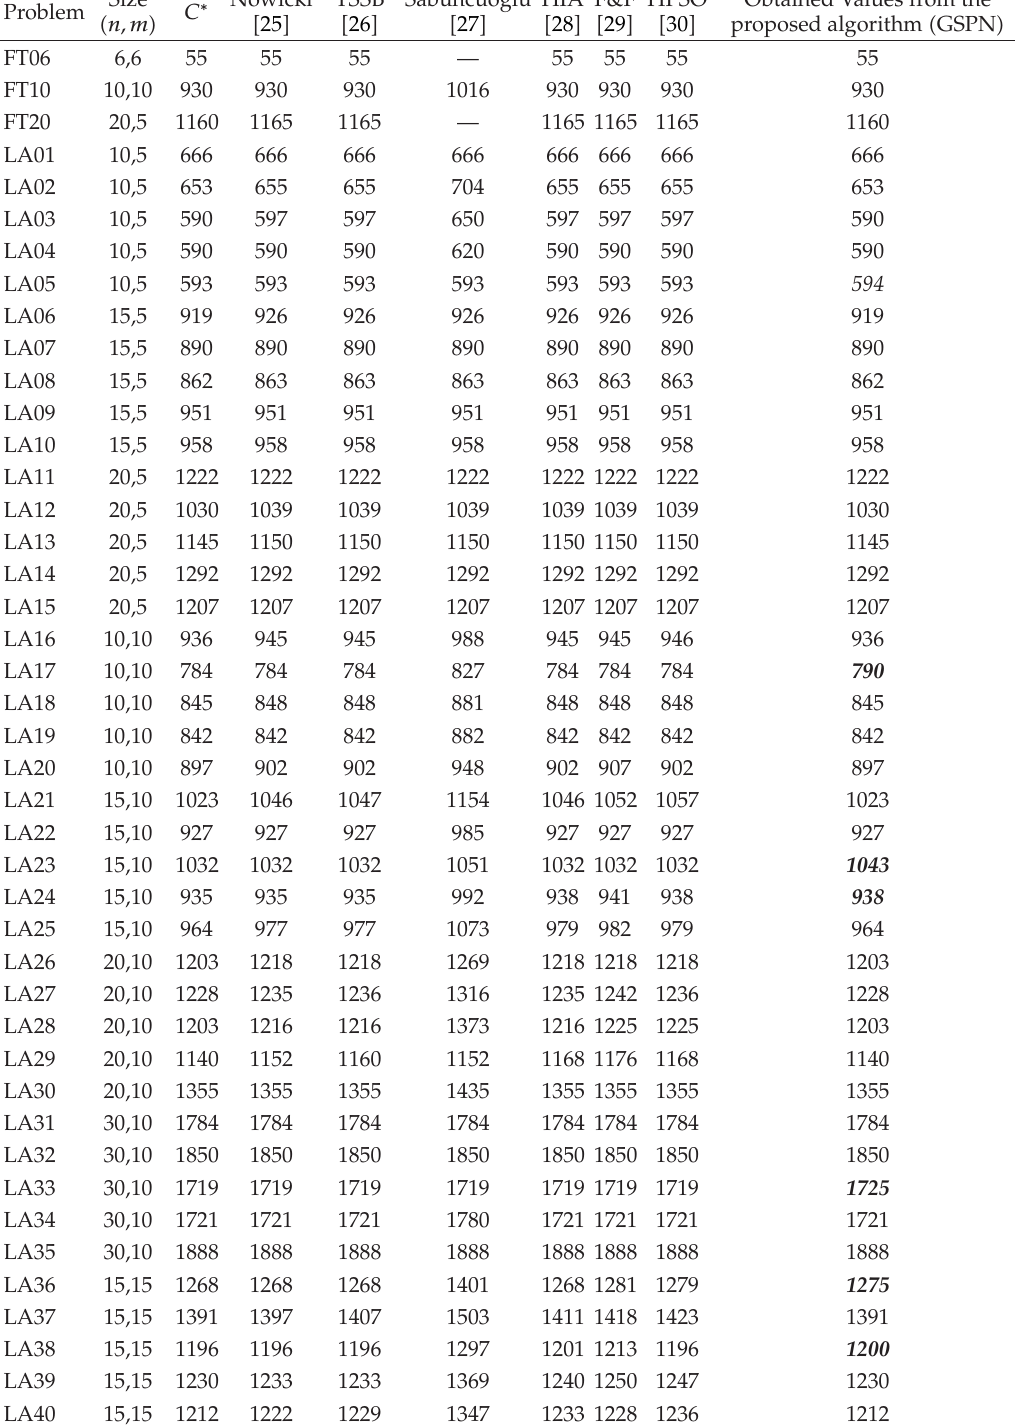
Table 4: Experimental